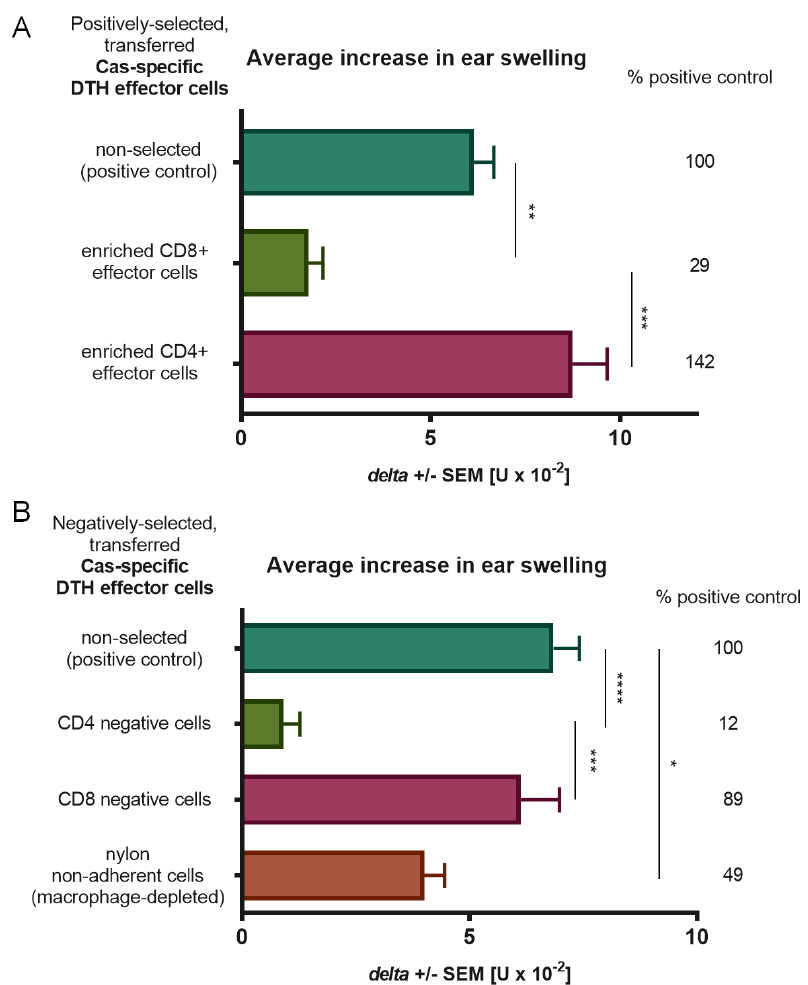
Figure 2. Phenotyping of effector cells of delayed-type hypersensitivity (DTH) to soluble casein (Cas) antigen. Mice had been intradermally (id) immunized with a saline solution of soluble Cas antigen (100 µg per mouse) 5 days before harvest of lymph nodes and spleens containing effector cells, which were then subjected to positive ( A ) or negative ( B ) selection assays by, respectively, magnetic-advanced cell sorting or depletion with either monoclonal antibodies and complement or nylon wool separation. Afterwards, selected effector cells were transferred to naive recipients, which 24 h later were challenged by id administration of the same Cas solution (5 µg per earlobe). After 24 h, ear swelling response was measured and expressed as delta ± SEM [units (U) × 10 -2 mm] (n = 5, N = 2), * p < 0.05; ** p < 0.01; *** p < 0.001; **** p < 0.0001.